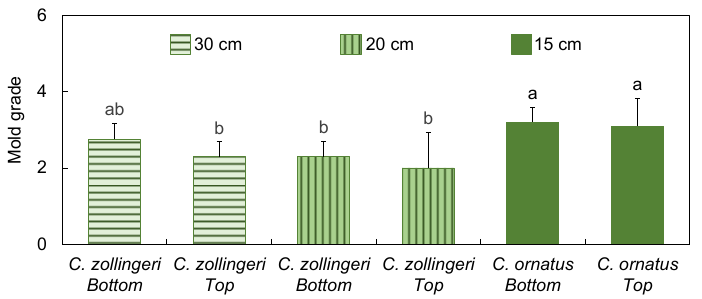
Figure 4. Mold grading of rattan samples for different diameter classes. Error bars show standard deviations. Bars with different letters indicate that there is a significant difference ( P ≤ 0.05), as determined by ANOVA and Duncan’s multiple range test.